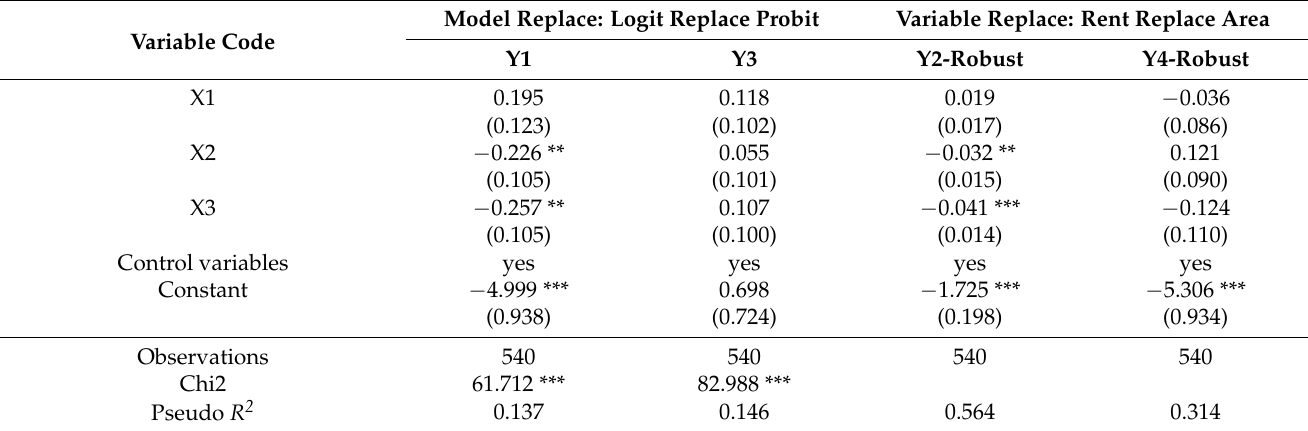
Table 4. The robust tests of the impact of land attachment on land